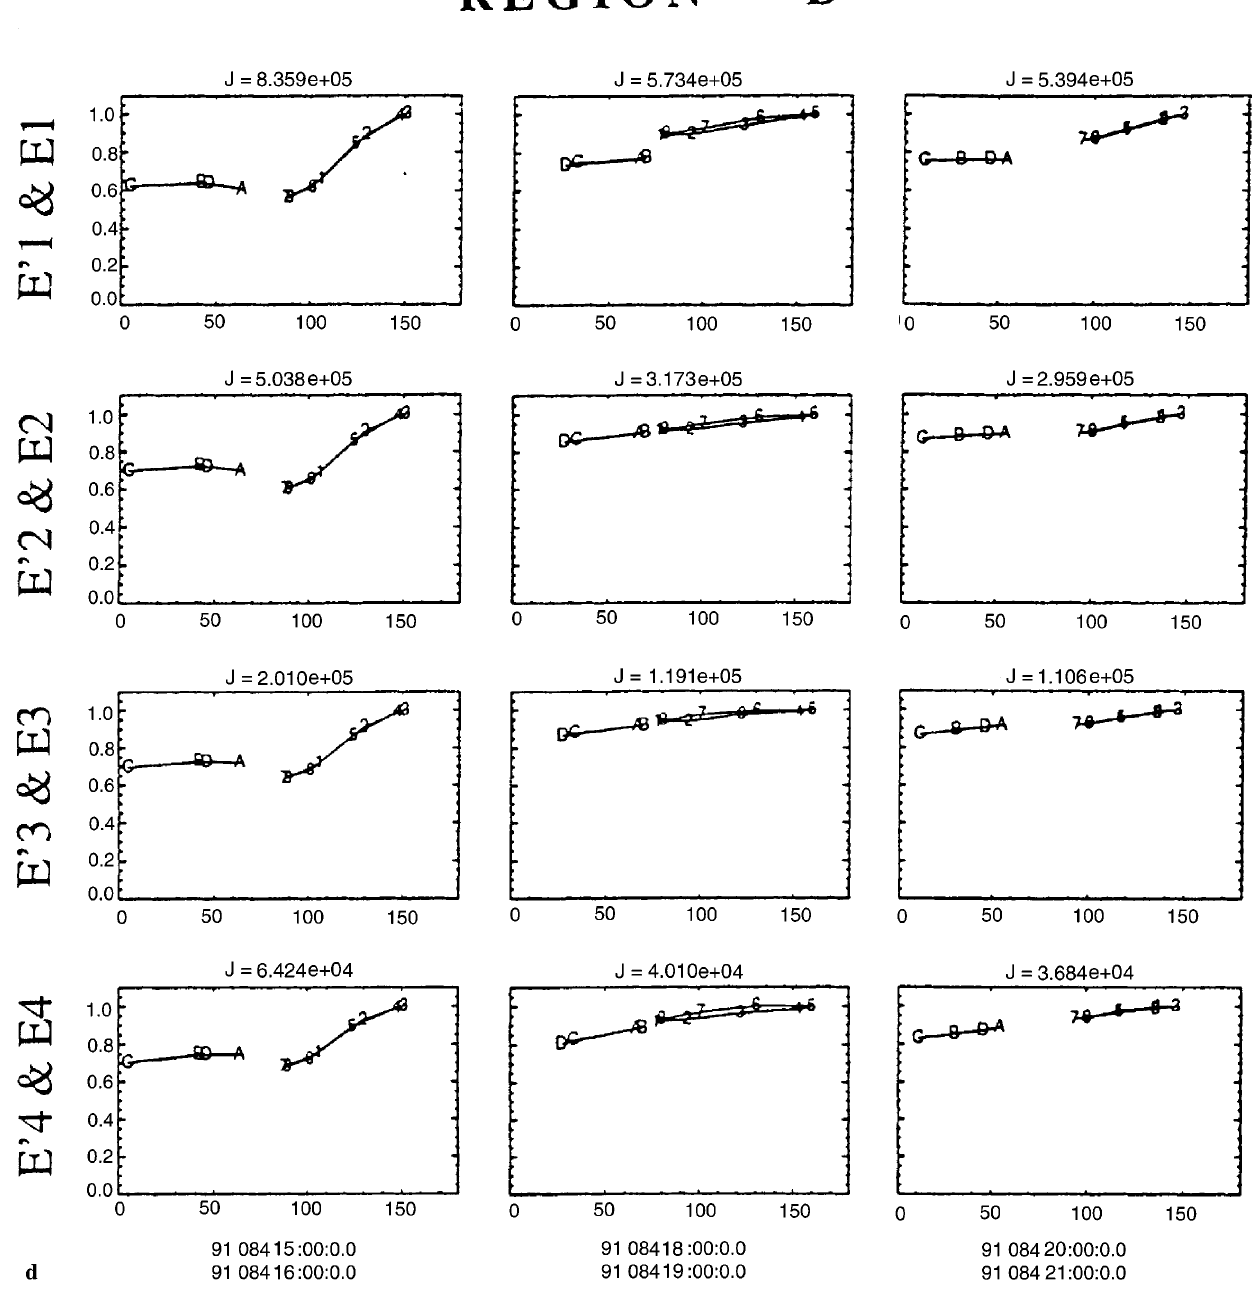
Fig. 2d. The electron population detected in region D exhibits unidirectional anisotropies directed anti-parallel to the IMF direction. Apparently electrons are streaming away from the Sun during